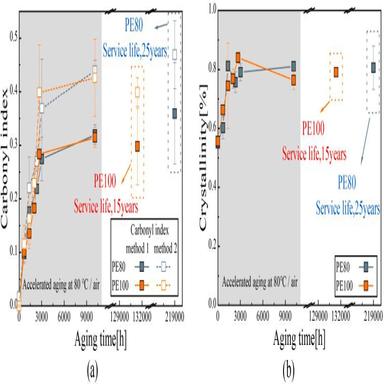
Carbonyl index (a) and crystallinity (b) change as a function of PE grades and aging time.